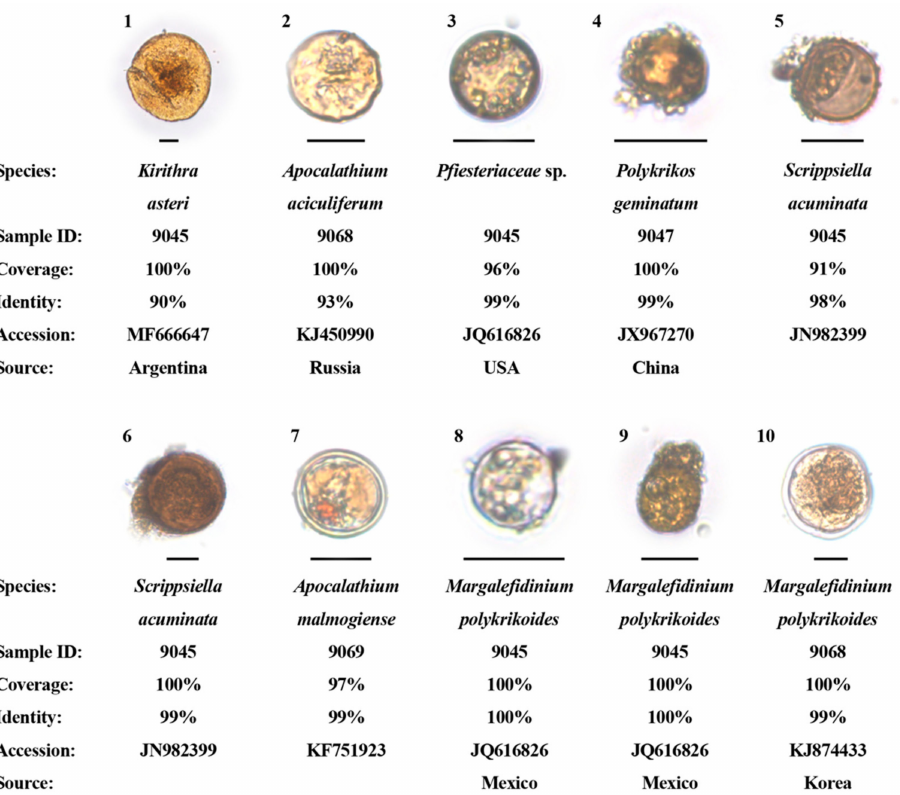
Figure 4. Dinoflagellate cysts identified by single-cell PCR and cloning sequencing from ballast tank sediments collected from ships entering the Great Lakes. Scale bars (lines at the bottom of micrographs of cysts): 20 µ m. The term “source” refers to the geographic origin of the reference entities (shown in accession